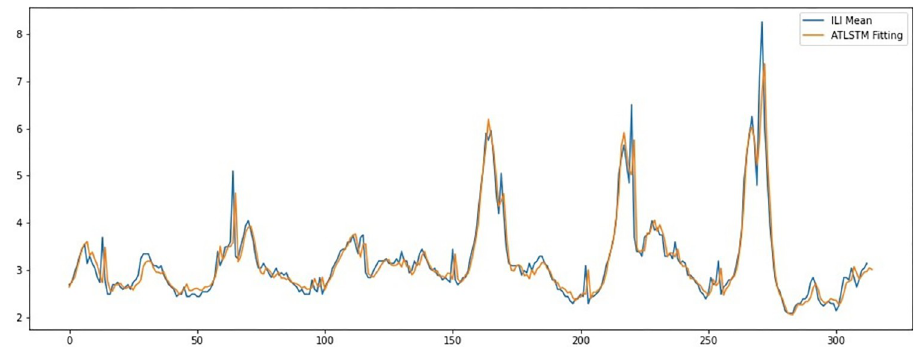
Fig 3. Fitting results of the attention-based LSTM model. The abscissa of this line chart is the time span (in week unit, containing the last 315 weeks of the training set, from the 49 th week of 2014 (December 1 st to December 7 th ), to the 50 th week of 2020 (December 7 th to December 13 th )), and the ordinate of this chart is the numerical value of ILI. In this chat the real numerical value of ILI mean data through the time span is shown as the blue line, and the algorithm return ILI value by using ATLSTM model in fitting the training dataset in the same time span is shown as the brown line. In this line chart, there is a high degree of fitness between the blue line and the brown line, which reveals the characteristics of the real ILI data are well captured by the ATLSTM by training based on the Baidu index data.